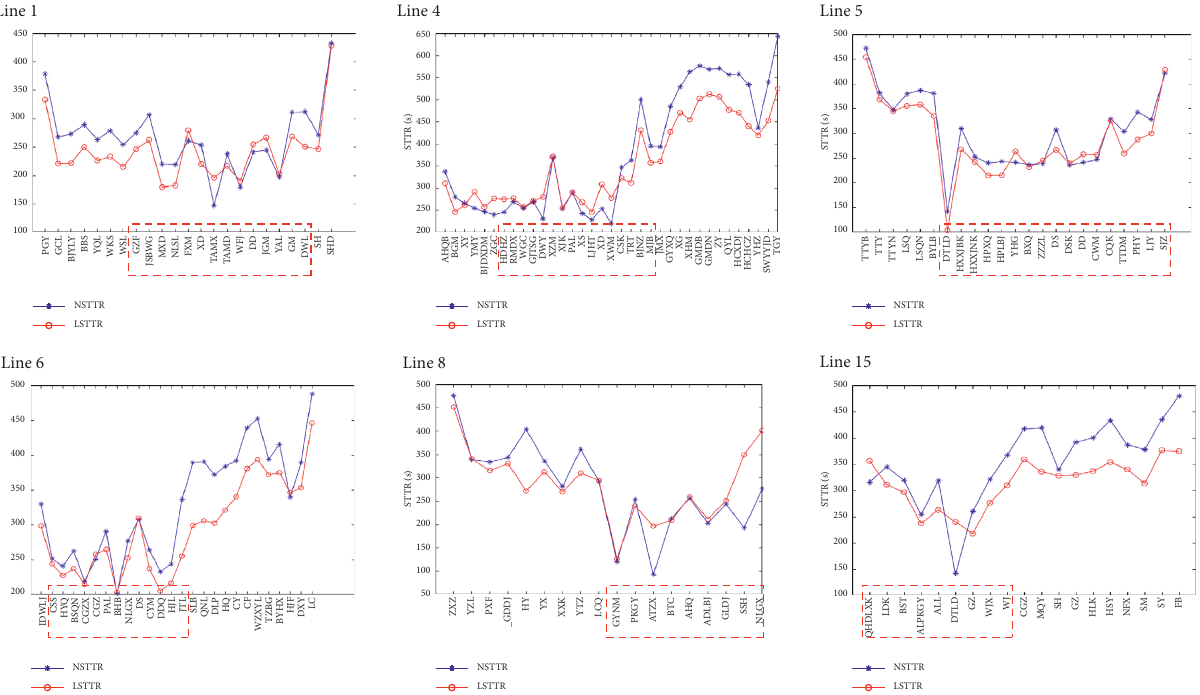
Figure 8: The values of NSTTR and LSTTR of six